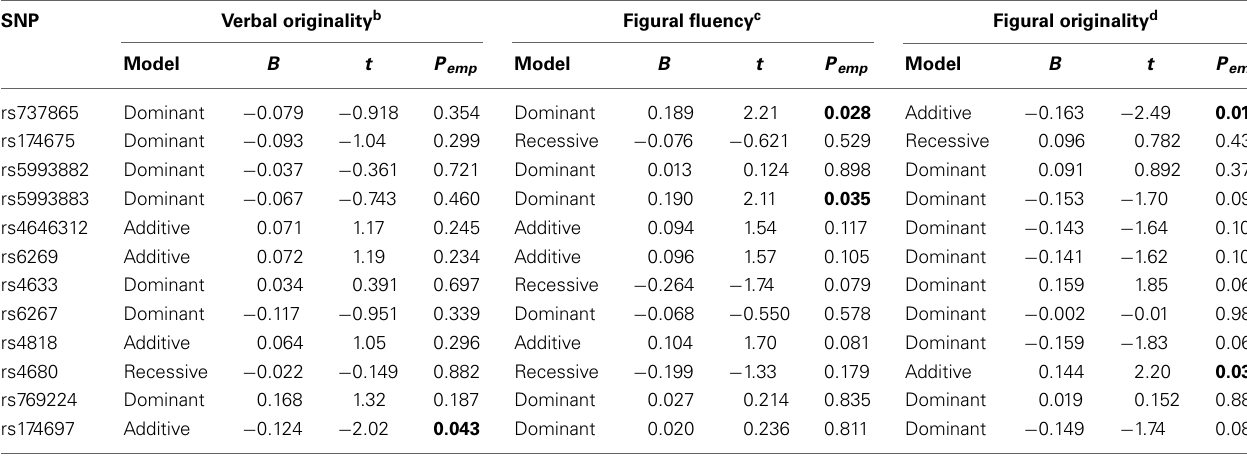
Table 3 | Selected results of single SNP analysis for creative potential a